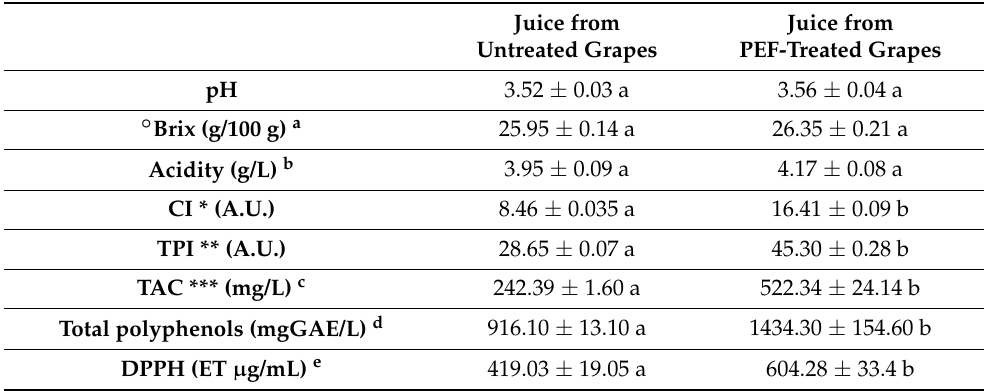
Table 1. Physico-chemical characterization of grape juices obtained from untreated and PEF-treated grapes after 24 h of maceration at 4 ◦